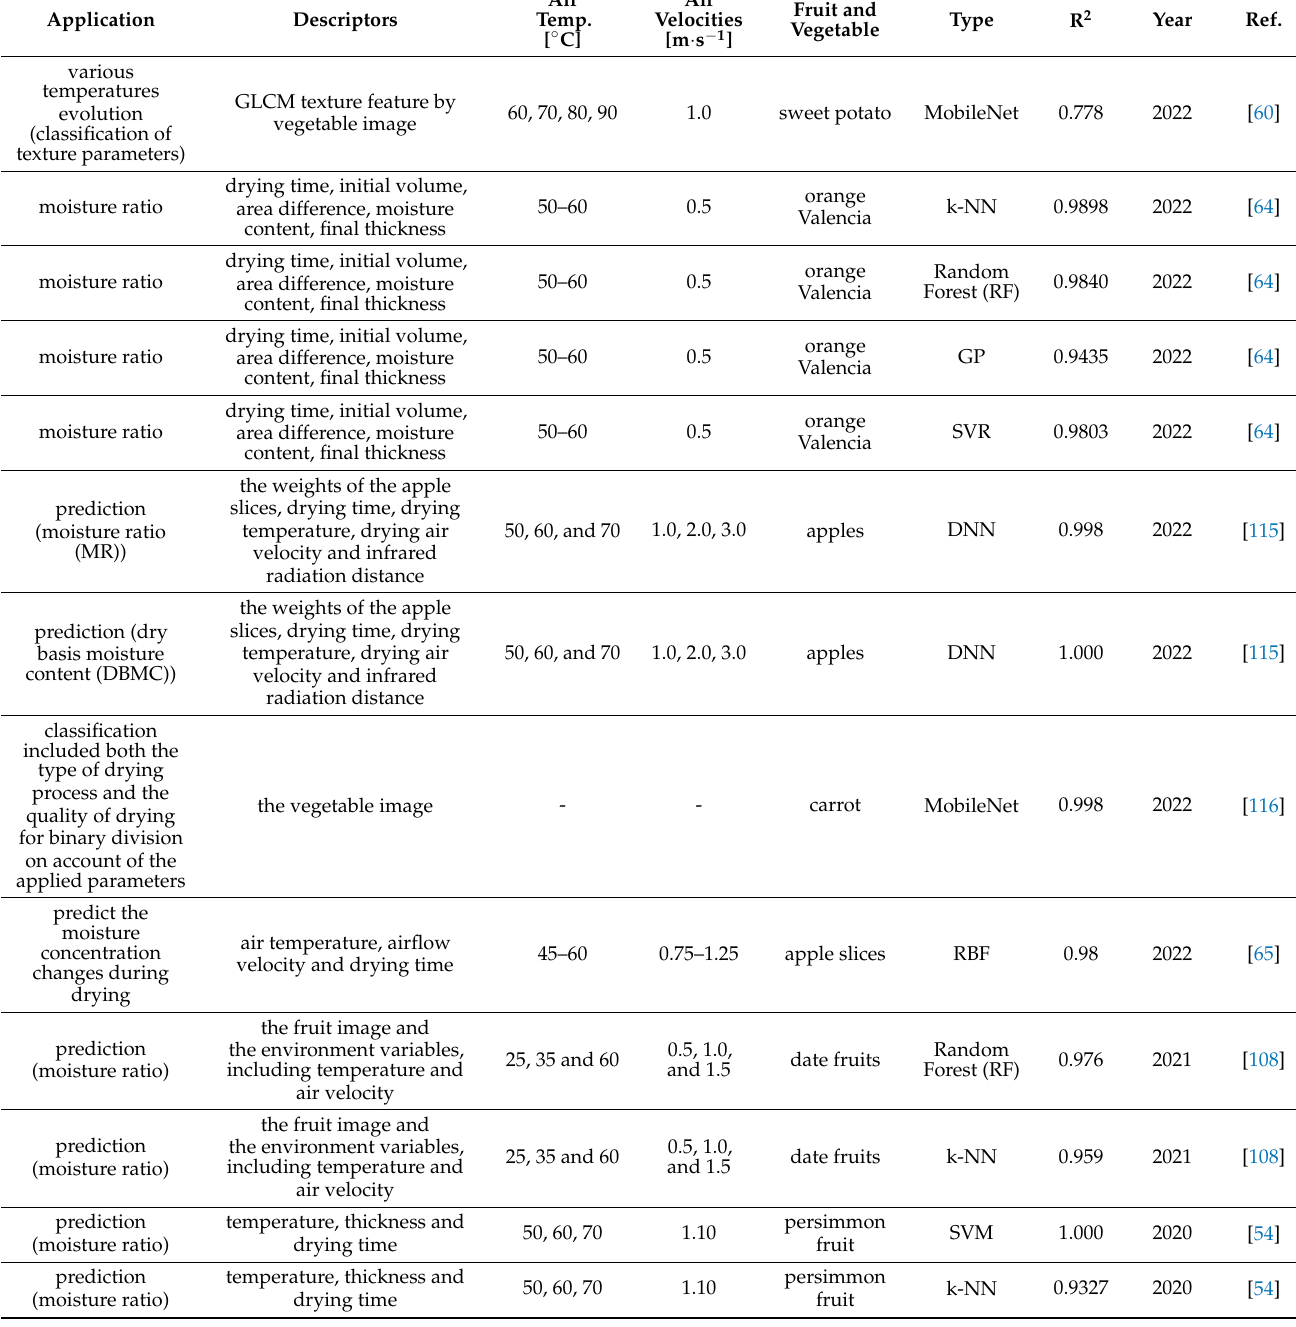
Table 3. Other methods of AI in